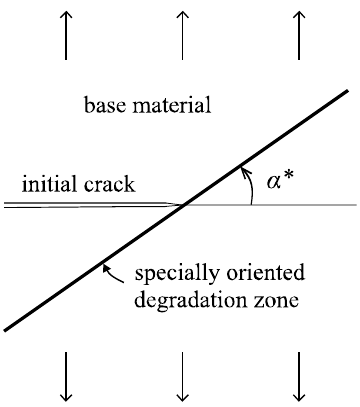
Figure 8: A Mode-I crack intersecting a line-degradation at angle  .